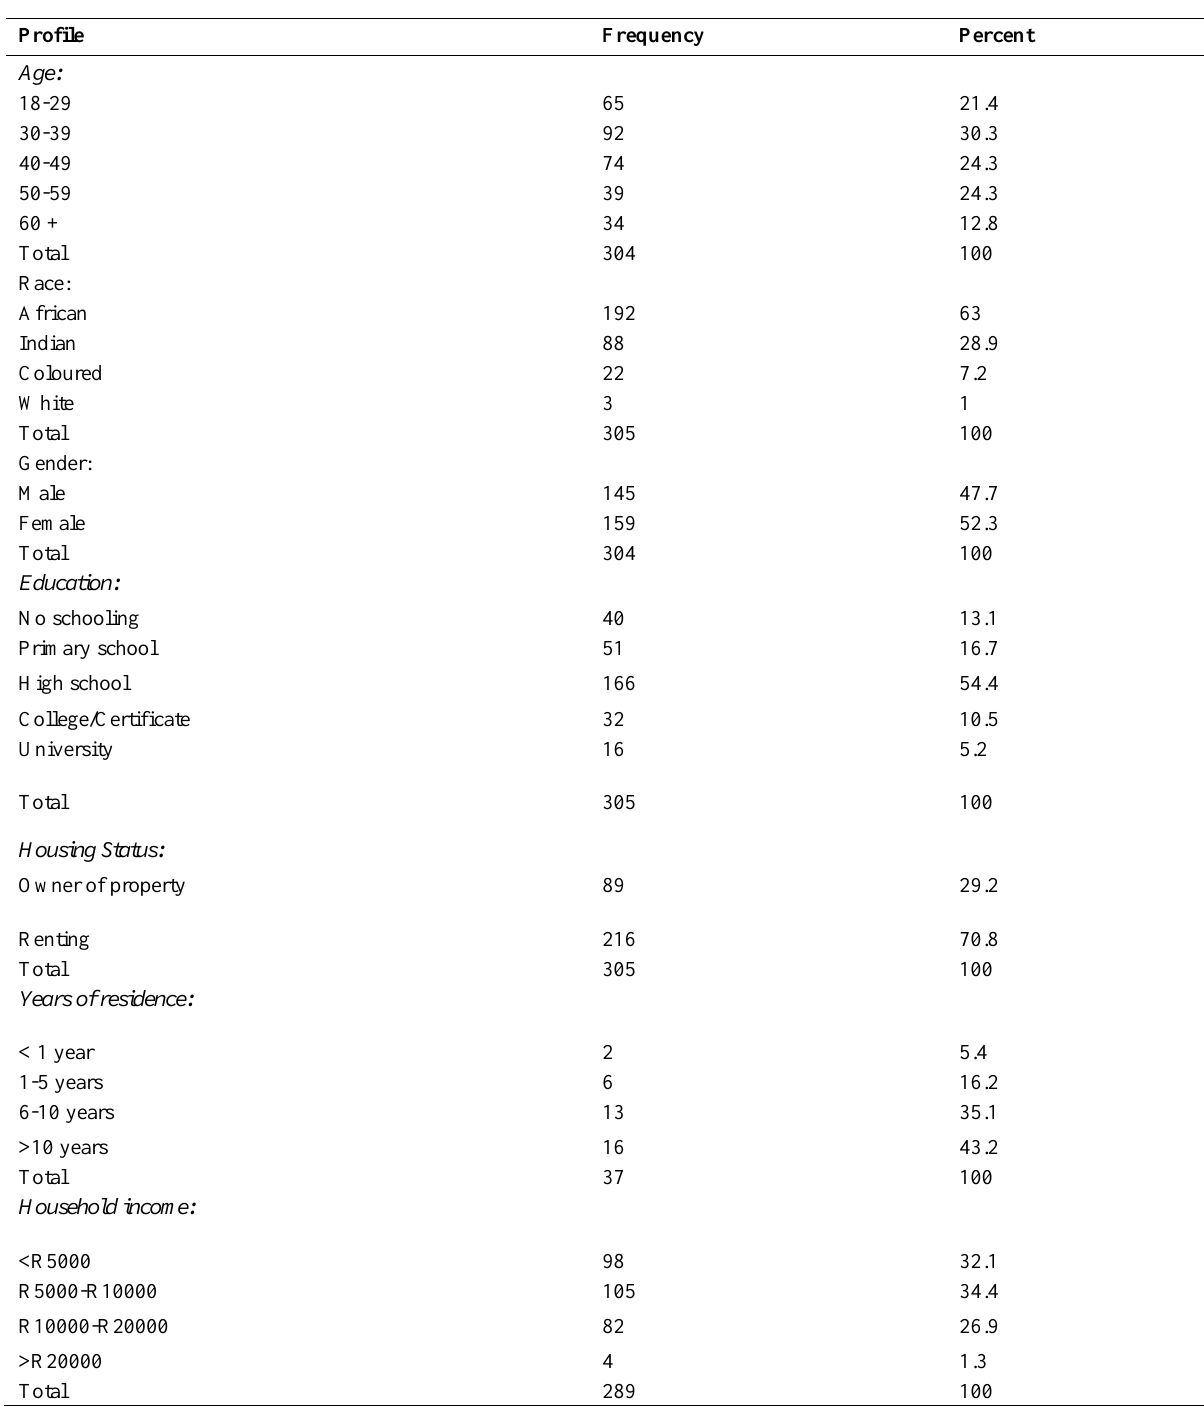
Table 1 : Demographical profile of